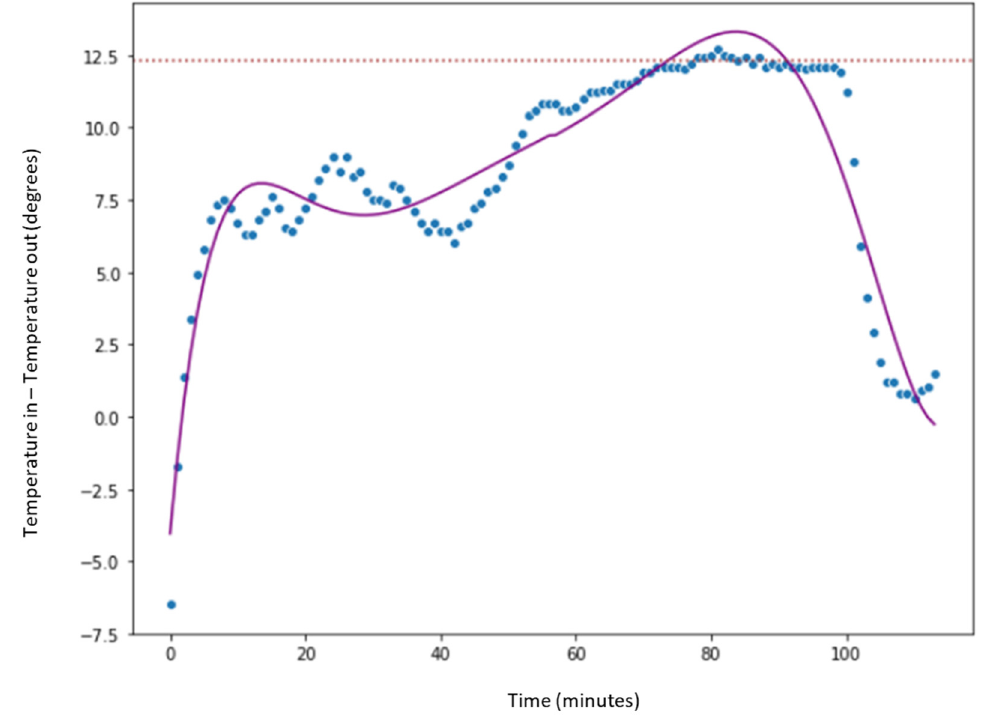
Figure 8. Preheating phase analysis of one batch of product.